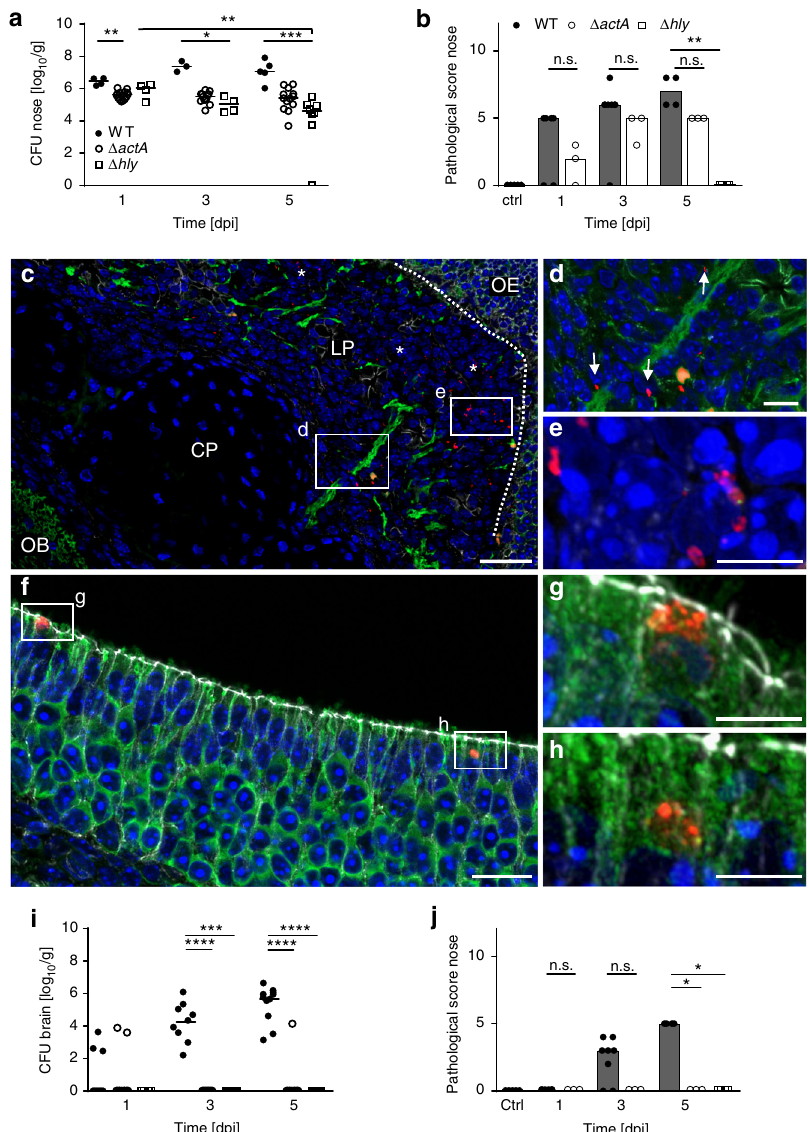
Fig. 8 LLO and ActA are essential for CNS invasion. Bacterial counts in a nose and i brain after i.n. infection of 1-day-old mice with 1 × 10 4 CFU wild-type Lm (WT) an isogenic ActA-de fi cient ( Δ actA ) Lm strain and an isogenic LLO de fi cient ( Δ hly ) Lm strain at 1, 3, and 5 dpi. WT Lm : n = 4 (1 dpi), n = 3 (3 dpi), n = 5 (5 dpi); Δ actA Lm : n = 14 (1 dpi), n = 13 (3 dpi), n = 13 (5 dpi), Δ hly Lm : n = 4 (1 dpi), n = 4 (3 dpi), n = 8 (5 dpi). Median; ANOVA Kruskal-Wallis with Dunnets ’ post test and for comparison of Δ hly Lm 1 dpi vs. Δ hly Lm 5 dpi unpaired, two-tailed Mann – Whitney test; n.s. p > 0.05; * p < 0.05; ** p < 0.01; *** p < 0.001; **** p < 0.0001. Histopathological score from HE stained nasopharyngeal tissue ( b ) and total brain tissue ( j ) as speci fi ed in Methods section. Each dot de fi nes an individual mouse. Control animals: n = 5; WT Lm : n = 6 (1 dpi), n = 8 (3 dpi), n = 4 (5 dpi); Δ actA Lm : n = 3 (1 dpi), n = 3 (3 dpi), n = 3 (5 dpi), Δ hly Lm : n = 4 (1 dpi). Median; unpaired, two-tailed Mann – Whitney test; n.s. p > 0.05; * p < 0.05; ** p < 0.01. Immunostaining of the olfactory mucosa after i.n. infection of 1-day-old mice with 1 × 10 7 CFU Δ actA ( c – e ) or Δ hly ( f – h ) Lm . Sections were stained for Lm (red), the neuronal marker β -tubulin III (green), the tight-junction marker β -catenin (white) and DNA (DAPI, blue). c Sagittal view of the olfactory mucosal tissue at 3 dpi with Δ actA Lm (scale bar 25 µ m). White asterisks indicate subepithelial Δ actA Lm , dotted line illustrates disruption of the OE. d and e Zoomed view of the framed insert in c , white arrows indicate Δ actA Lm ( d : scale bar 10 µ m, e : scale bar 5 µ m). f Sagittal view of the OE at 1 dpi with Δ hly Lm (scale bar 20 µ m). g and h Zoomed view of the framed inserts in f (scale bar 5 µ m). The images are representative for samples from each n = 6 (BD Bioscience, Catalog No.: 559864, 1:100) to label most leukocytes, an rat anti- Catalog No.: 112-605-003, 1:500). Coverslides were mounted with Vectashield CD11b antibody conjugated with PE to label myeloid cells (BD Bioscience, Catalog Mounting Medium with DAPI (Vector Laboratories, Catalog No.: H-1200). No.: 553311, 1:100). The FITC-conjugated goat-anti-rabbit antibody (Jackson, Catalog For analysis of in fl ammatory distributions in the CNS, collected brains were fi xed No.: 111-096-045, 1:100) was applied as secondary antibody. with 4% PFA for 24h. Afterwards, fi xed brains were incubated overnight with 2% PFA/PBS containing 30% sucrose, embedded in OCT compound (Tissue Tek), cut into 7 μ m thick sections (Leica CM3050 S) and stored in a − 20°C freezer. For staining, sections were rehydrated in Tris-buffered saline with 0.05% Tween-20 (Sigma) (named TBST), blocked with 5% rat serum and 10% Fc block (Rat IgG 2b kappa; clone: 2.4G2) diluted in 1× TBST. Lm was labeled using a rabbit anti- Lm (Meridian Life Science, Catalog No.: B65420R, 1:3000), a mouse anti-CD45 antibody conjugated with PE (BioLegend, Catalog No.: 103106, 1:100) or conjugated with APC